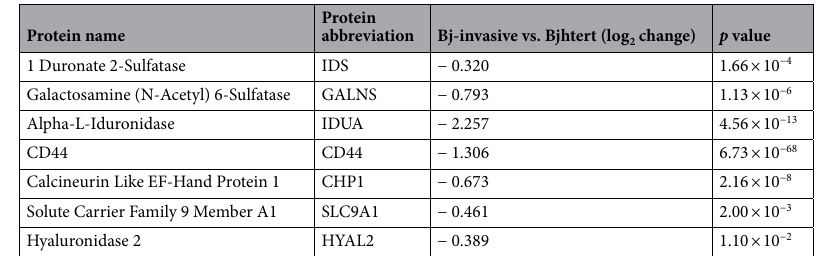
Table 2. Down-regulated hyaluronan-related gene expression in invasive (Bj-invasive) relative to normal control child fibroblasts (Bjhtert).